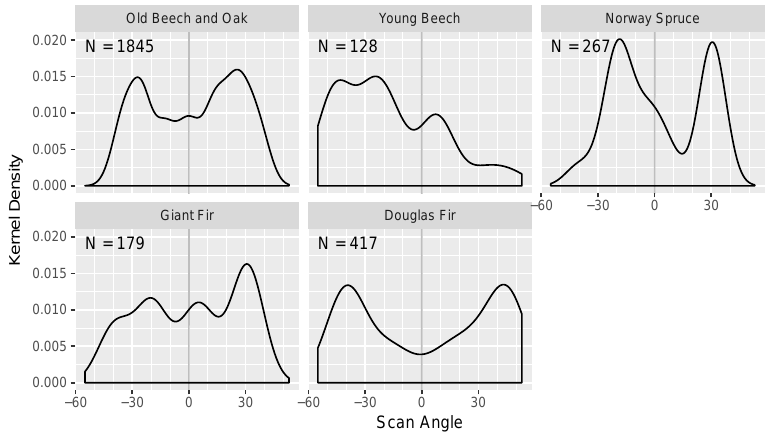
Figure 10. ALS scan angles under which the points considered for the DBH estimation were observed. N denotes the number of points for each